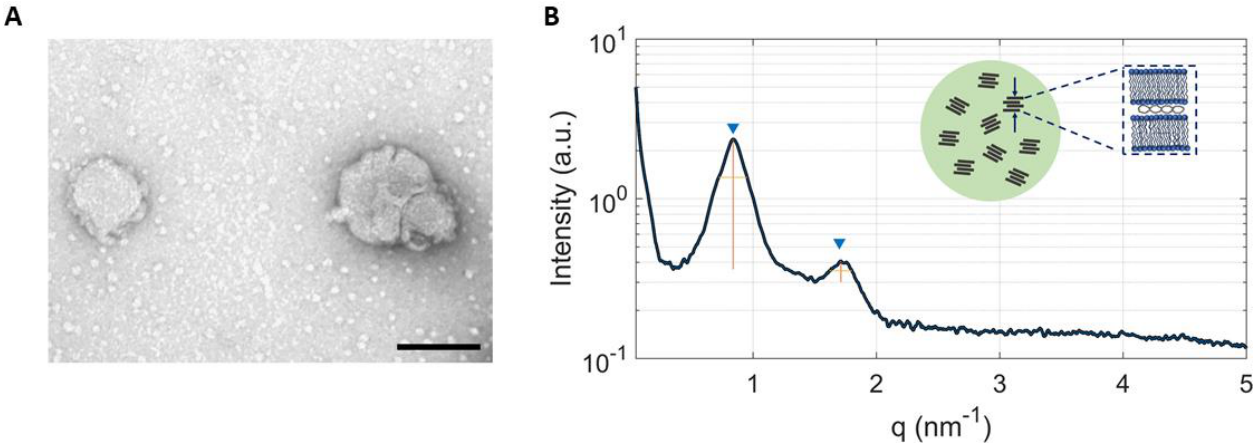
Figure 3. TEM image of PEGylated LNPs ( A ) (scale bar = 100 nm) . Synchrotron SAXS pattern of PEGylated LNPs ( B ). The broad peaks arose from the lamellar periodicity along the normal to the lipid bilayer, d, which is the sum of the membrane thickness (dB) and the thickness of the water/DNA layer (dW): d = dB + dW. From the fwhm of the first-ordered Bragg peak we estimated an average domain size made of 4 repeat units. Inset: cartoon describing the nanostructure of LNPs. Randomly oriented lamellar domains coexist within a single particle.